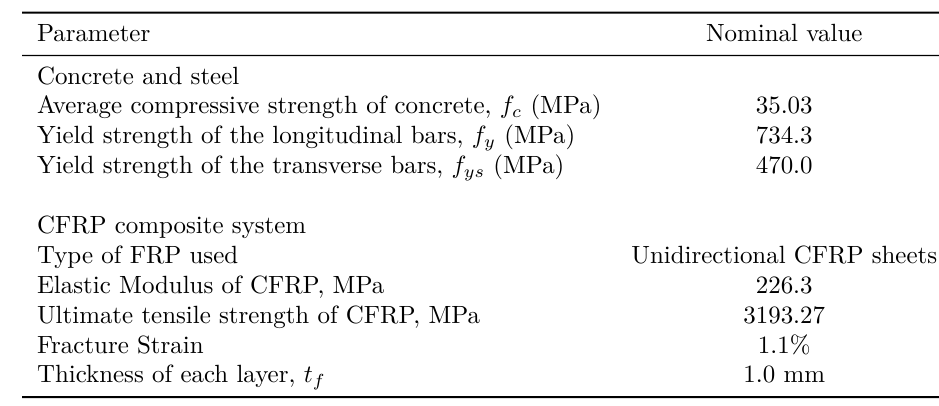
Table 1. Material Properties.